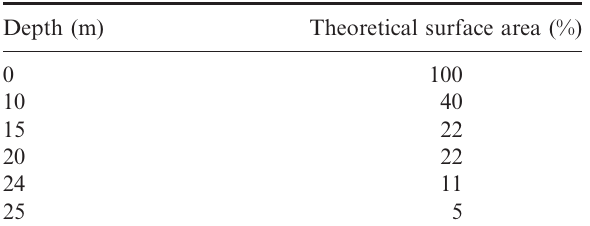
Table 4. Relation between the depth and the resulting theoretical surface area of the disposal pond (Stottmeister et al. 2009)